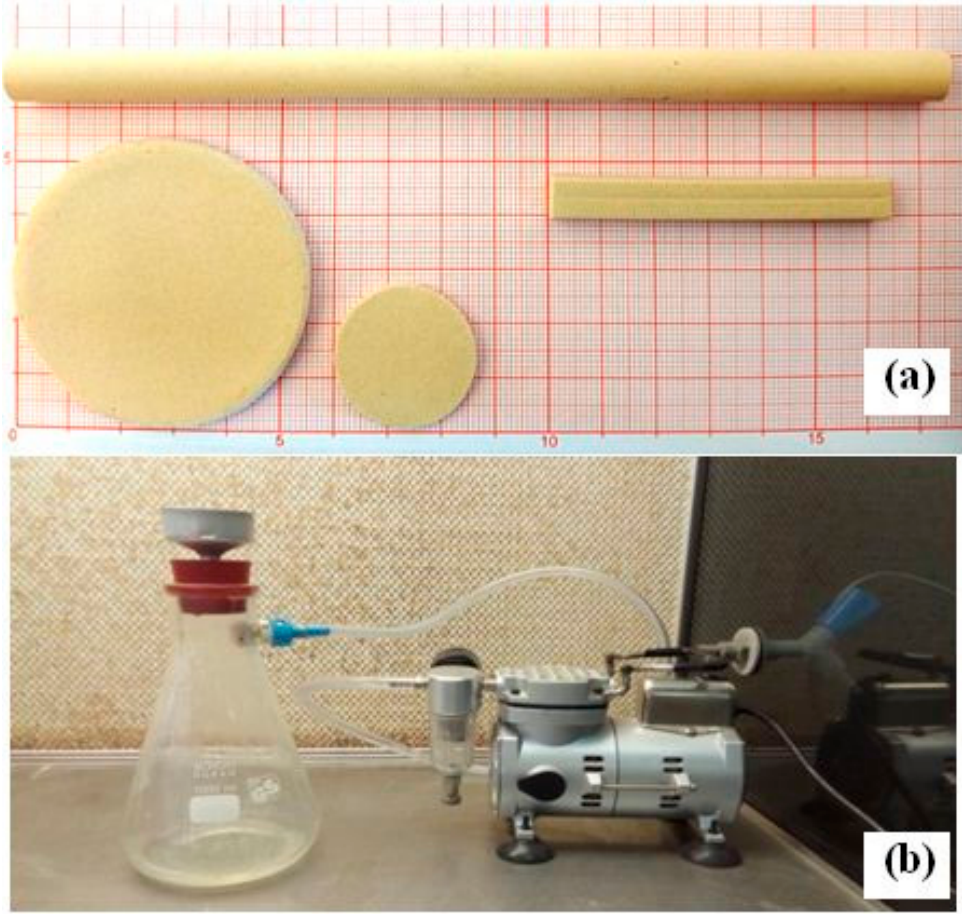
Figure 1. ( a ) A photograph of prepared samples: tube, flat disc, and flat rectangular. ( b )A photograph of the experimental installation used in frontal MF.